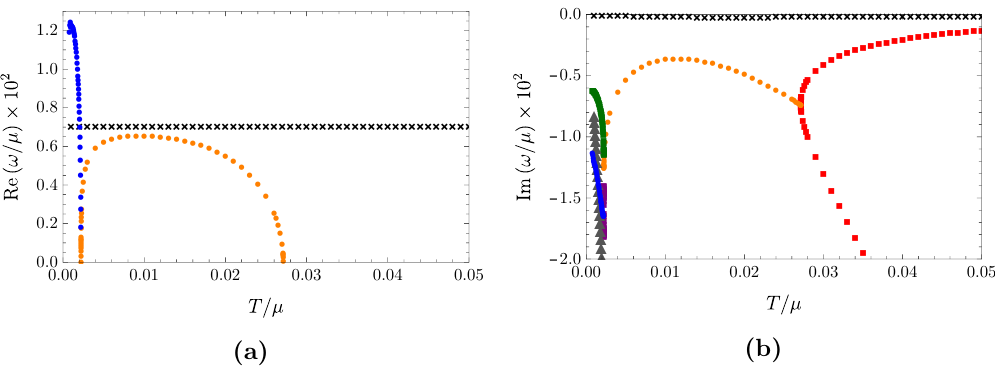
Figure 7. The same data as (cid:12)gure 6, but with separate plots for (a) Re ( !=(cid:22) ) and (b) Im ( !=(cid:22) ), each enhanced by 10 2 for clarity, as functions of T=(cid:22) . The pole motion is considerably more complicated than the previous smaller (cid:28) cases, so for detailed descriptions of the poles and their movement, including the color and shape coding, see the accompanying